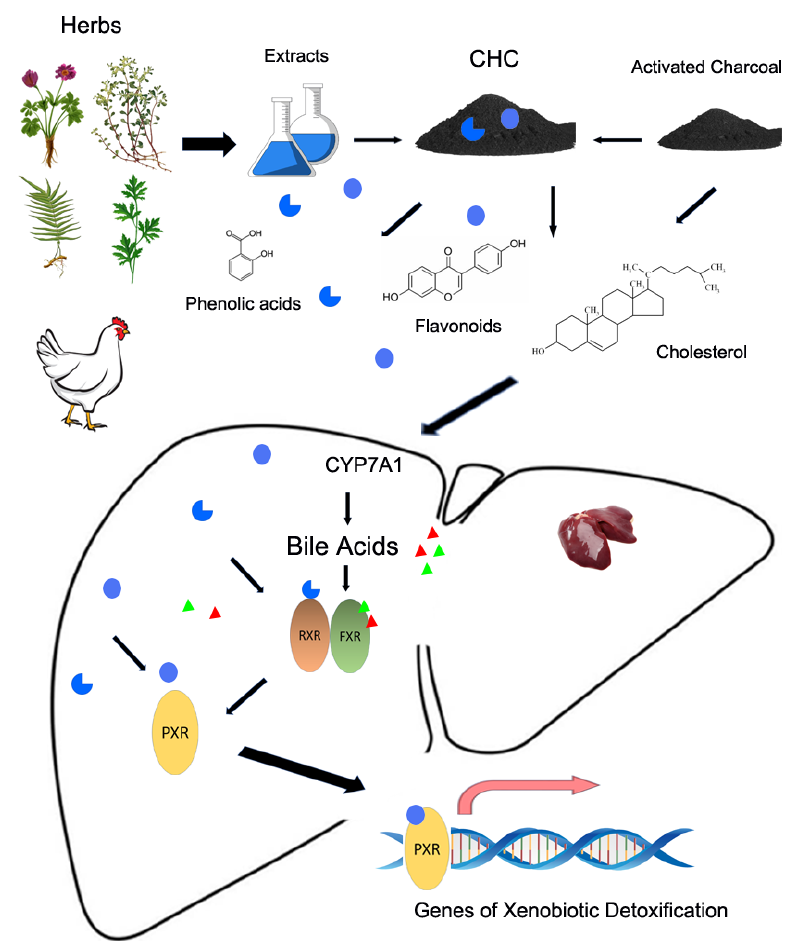
Figure 6. A working model of CHC promotes bile acid metabolism and xenobiotic detoxification in livers of broilers fed with mycotoxin-containing diets. CHC contains two portions: activated charcoal and herb extracts. The portion of activated charcoal can increase cholesterol level, which is the precursor of bile acid synthesis. Phenolic acids and flavonoids increase the synthesis of bile acids such as CDCD, LCA, and CA by enhancing CYP7A1 expression. These bile acids are the ligands that activate the farnesoid X receptor ( FXR ) transcription factor. The portion of herb extracts contains multiple types of flavonoids and phenols, including daidzein, quercetin, and genistein, which are the ligands that activate the pregnane X receptor ( PXR ), a crucial transcription factor in drug metabolism. Herb extracts also contain numerous types of phenolic acids such as caffeic acid and vanillin, which are potentially active ligands of the retinoid X receptor ( RXR ). FXR and RXR can form a heterogenous dimer to promote the expression of PXR . Subsequently, PXR activates the expression of genes for xenobiotic detoxification. Therefore, there are two pathways for the activation of PXR : 1 (cid:13) Activation of the FXR-RXR heterodimer by bile acids and phenolic acids that act on the PXR gene promoter, and 2 (cid:13) Activation of PXR by ligand (flavonoids, phenolic acids, or bile acids) binding. Separately, activated charcoal or herb extract, at a dose similar to that of CHC, is not sufficient to activate PXR to trigger the expression of the genes for xenobiotic detoxification. CHC integrates the cooperative interactions between the activated charcoal and the herb extract (CHC) in this detoxification process. Herbs: Pulsatilla chinensis ( top left ), Portulaca oleracea L . ( top right ), Artemisia argyi Folium ( bottom left ), and Pteris multifida Poir ( bottom right ). CDCA, chenodeoxycholic acid; LCA, lithocholic acid; CA, cholic